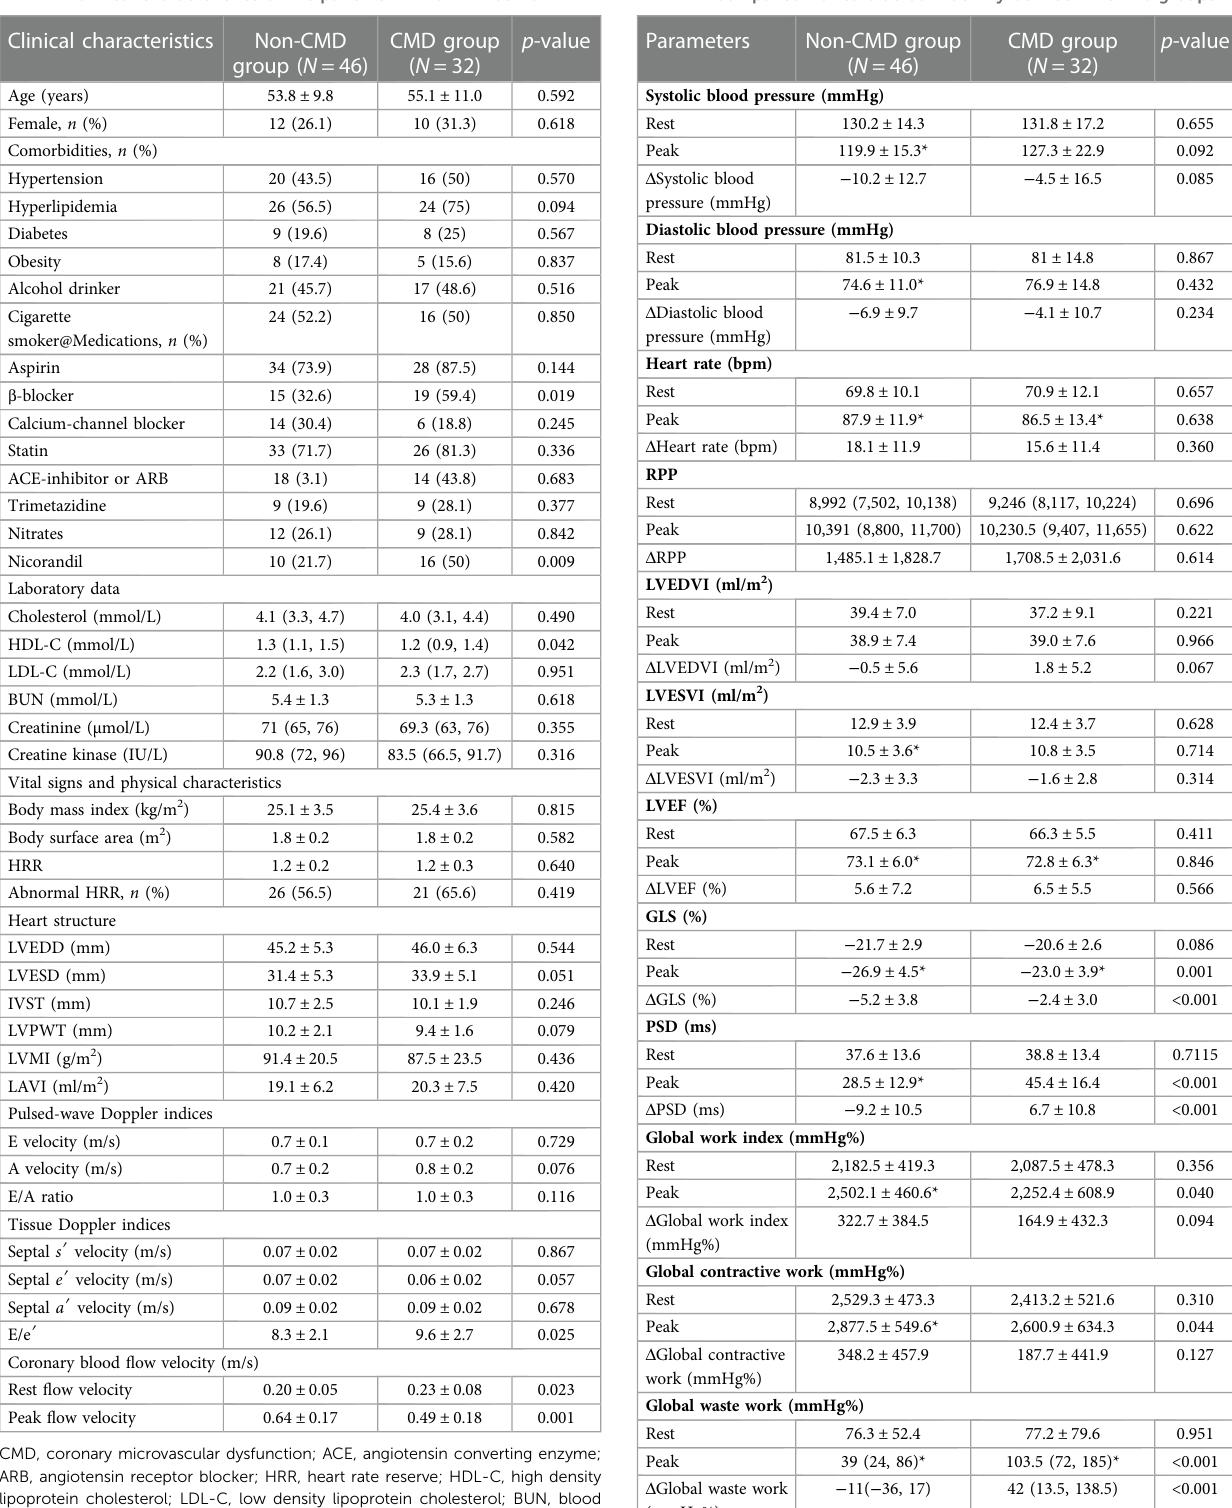
TABLE 2 Comparison of cardiac contractility between the two